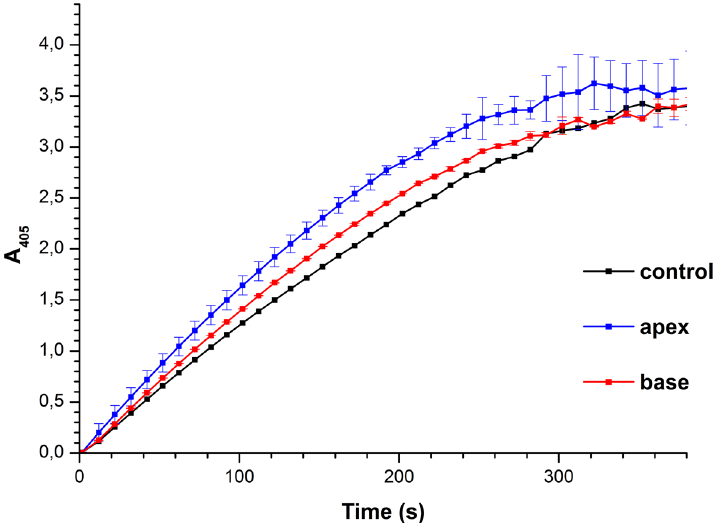
Figure 3. Time dependencies of the absorption at 405 nm obtained for the HRP samples in control experiments (black curve) and after the incubation of the HRP solution either near the apex of the pyramid (blue curve) or in the center of its base (red curve). Experimental conditions: HRP:ABTS:H 2 O 2 = 10 −9 M:0.3 mM:2.5 mM, room temperature (22